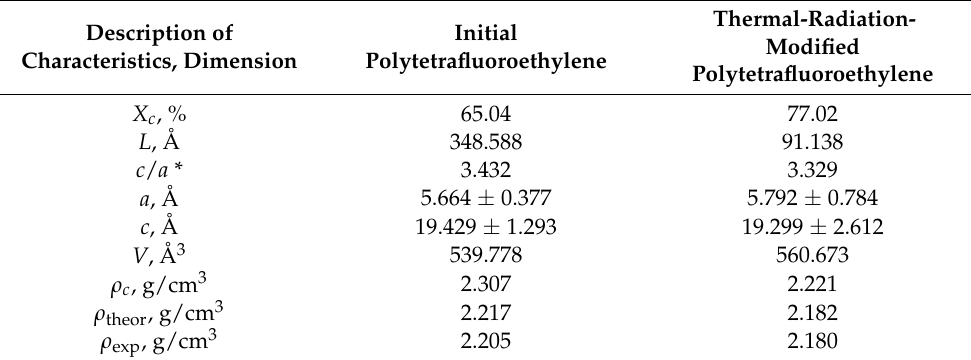
Table 2. Degree of crystallinity X c , average crystallite size L , lattice constants a and c , volume V of the unit cell, and the X-ray density ρ c of the initial and thermal-radiation-modified polytetrafluo- roethylene samples.